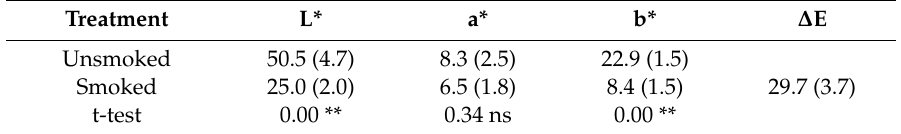
Table 5. Color of unsmoked and smoked wood specimens.